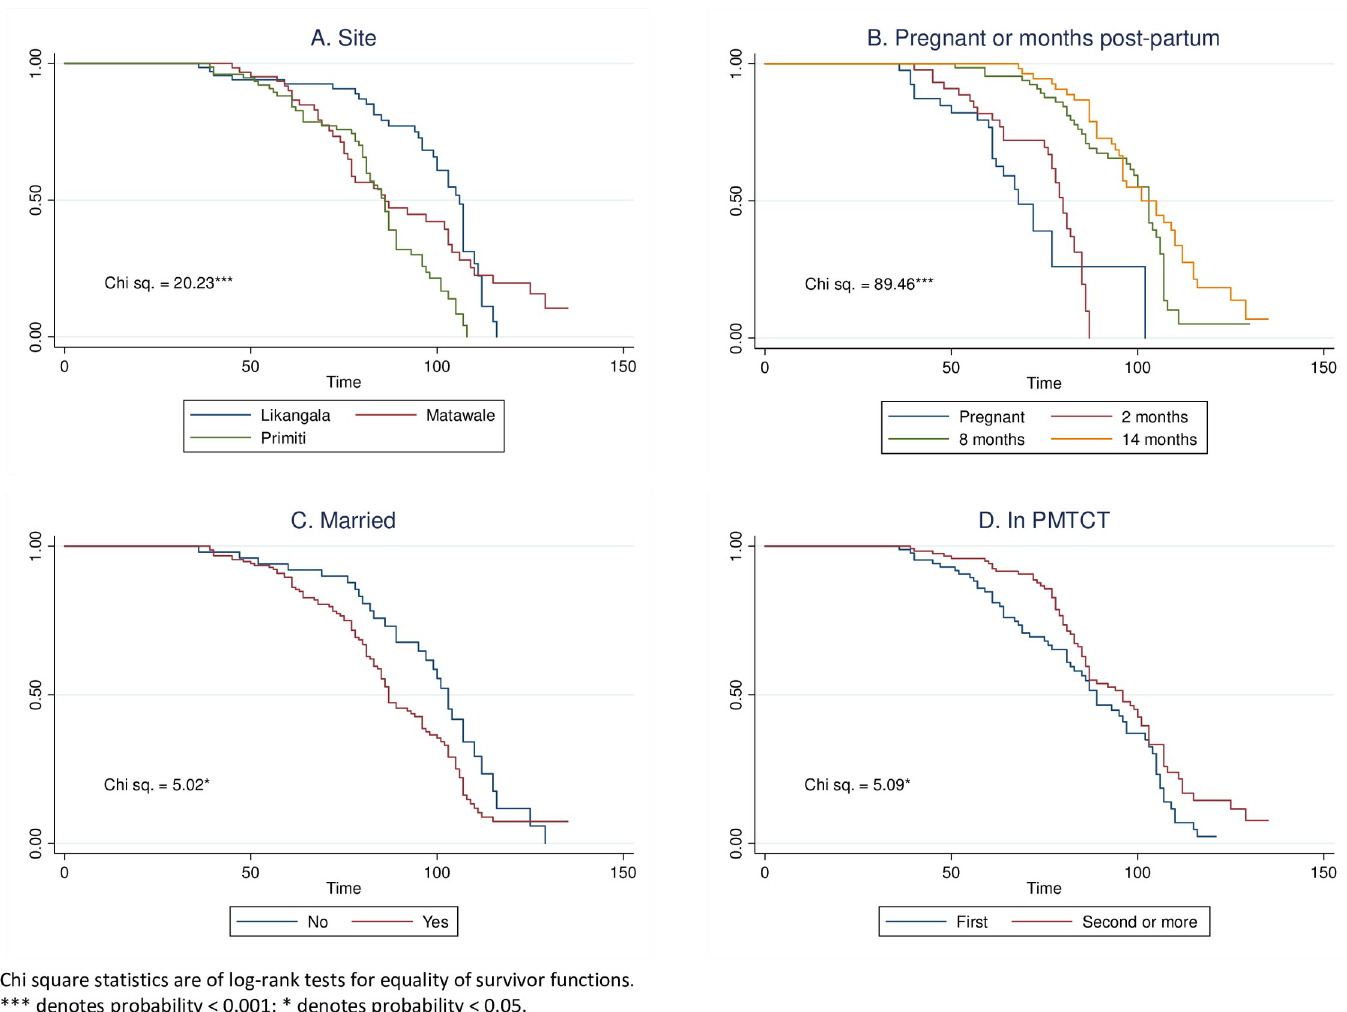
Fig 5. A–D. Kaplan-Meier curves representing time to first non-adherence by (A) site, (B) group, (C) marital status, and (D) prior experience with PMTCT.